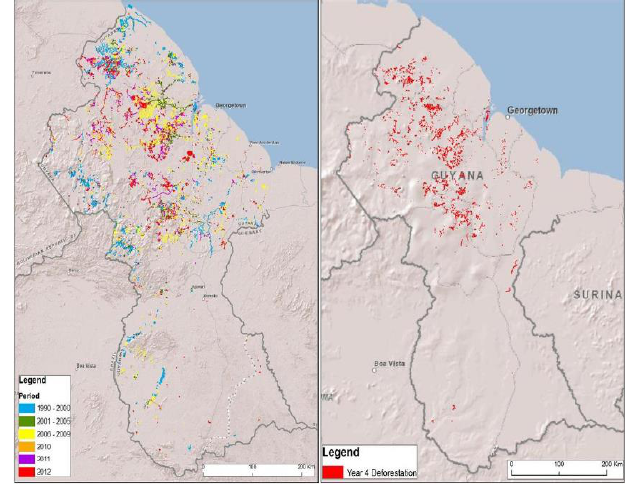
Figure 7: Historical and year 4 forest change © The Guyana